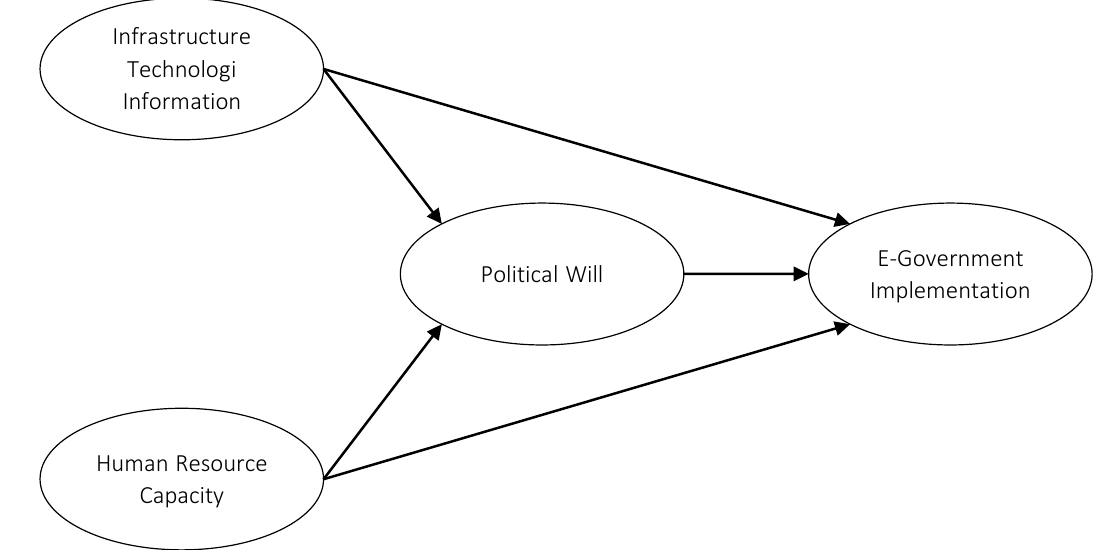
Figure 1. Research conceptual